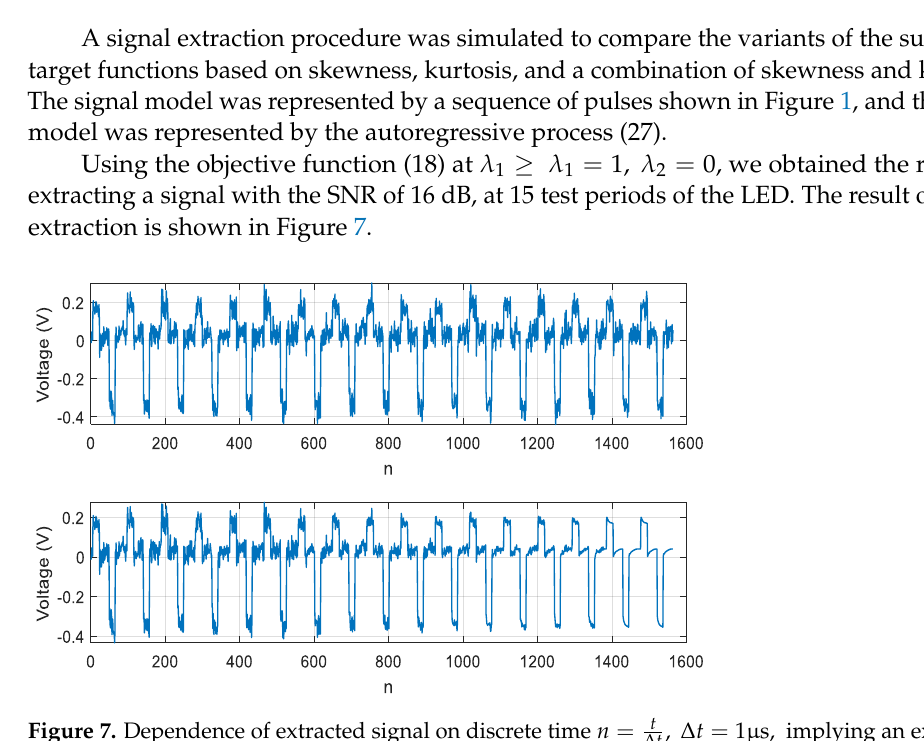
, ∆ t = 1 µ s, implying an extraction t